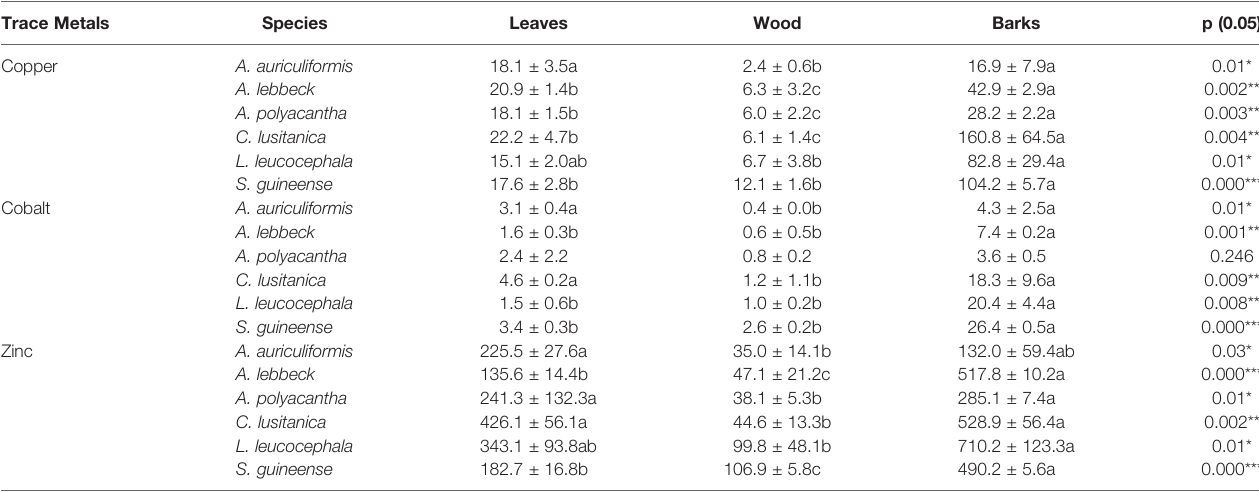
TABLE 7 | Comparison of trace metal concentration in leaves, wood, and barks of tree species (mg kg − 1 dry weight; n = 2). Trace Metals